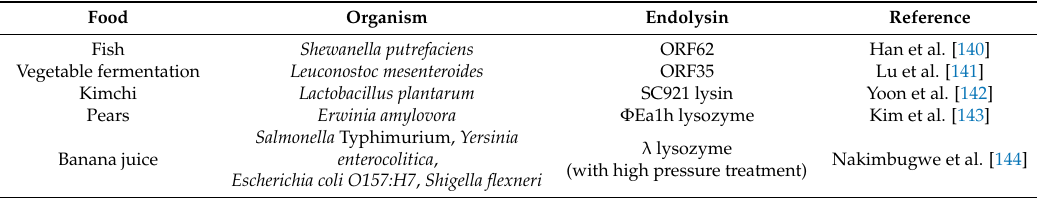
Table 2. Examples of other potential uses of endolysins in